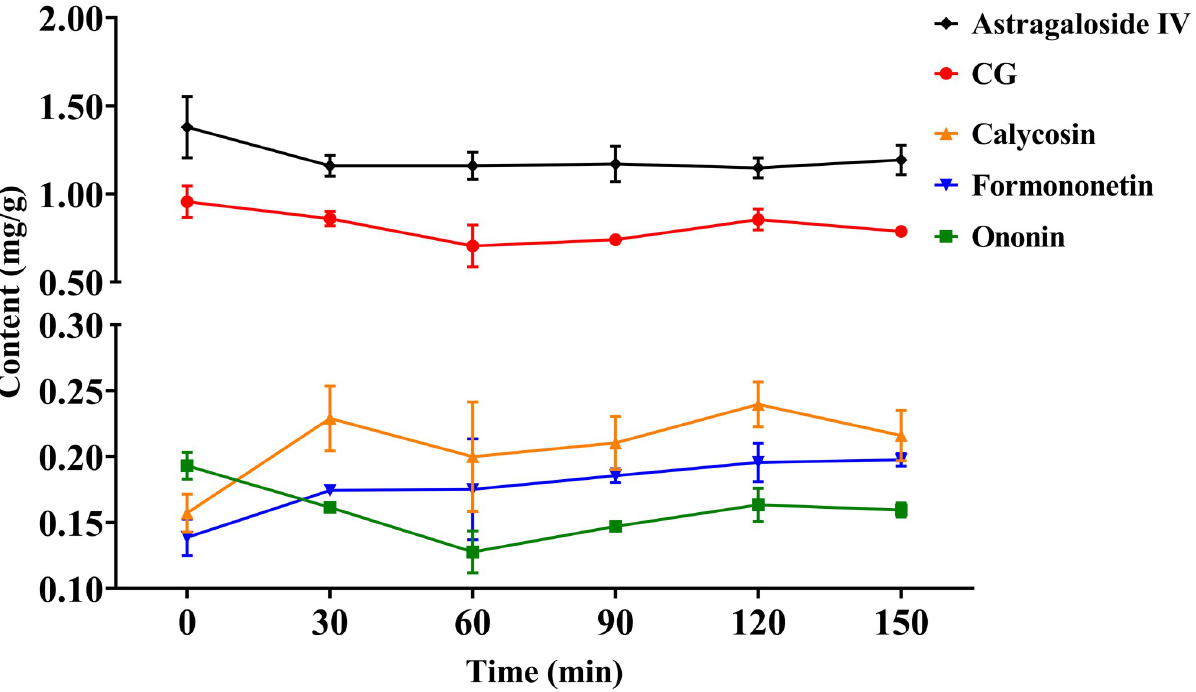
Fig 2. Contents of CG, calycosin, ononin, formononetin and astragaloside IV in AR pieces during drying at 80˚C. Data are represented as the mean ± standard deviation of three independent experiments.